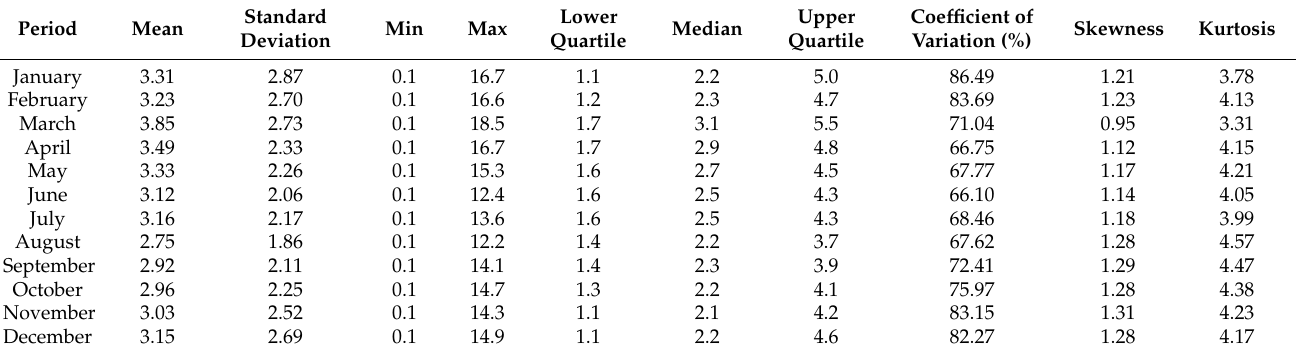
Table 1. Descriptive statistics of respective months.